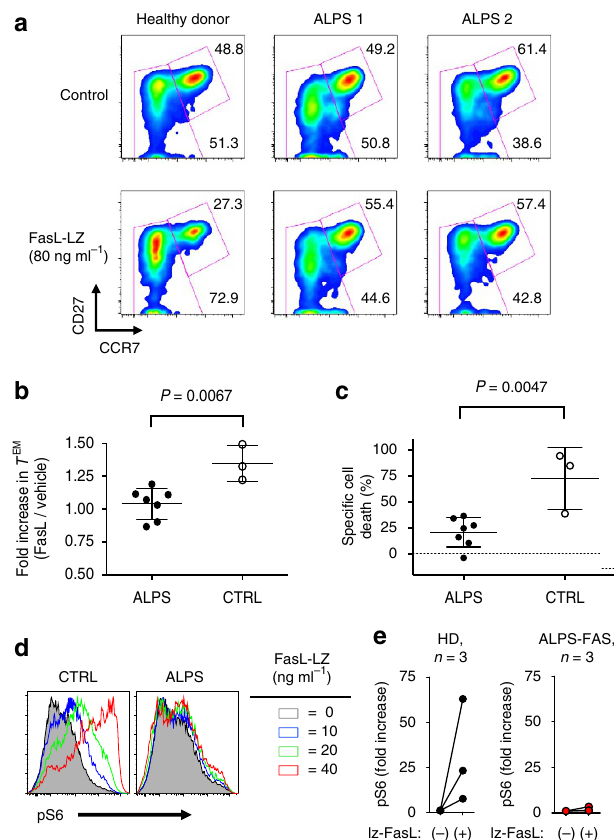
Figure 8 | ALPS patient T cells are defective in Fas-induced differentiation and apoptosis. ( a ) Representative data with PBMCs from two unrelated ALPS patients with Fas death domain mutations and a healthy donor control, activated for 7 days with or without FasL-LZ as described in the ‘Methods’ section. Differentiation of CD8 þ T cells was examined by staining for surface CD27 and CCR7. Cells were gated CD3 þ CD4 (cid:2) CD8 þ before analysis of CD27/CCR7 status. ( b ) Summary of fold increase in effector memory Tcells by FasL-LZ, in seven ALPS patients ( N ¼ 7) and three normal donor controls ( N ¼ 3) from two independent experiments. Cumulative data are represented as mean ± s.e.m. ( c ) Cumulative specific cell death induced by FasL-LZ in cell cultures shown in b from two independent experiments. P -values are from an unpaired t -test, with data represented as mean ± s.e.m. ( d , e ) Intracellular staining for pS6 was performed on isolated CD8 þ T cells from three healthy donors ( N ¼ 3) and three ALPS patients ( N ¼ 3), with representative FACS plots ( d ) shown. Summary of data are shown in e , with fold increase calculated